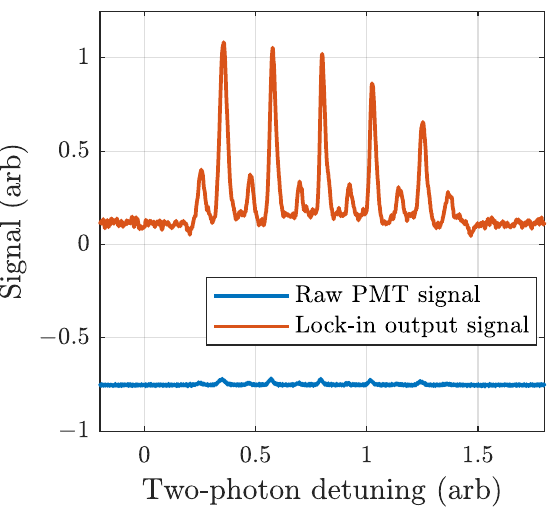
Figure 7. Raw Raman spectrum (blue) and output from the lock-in amplifier